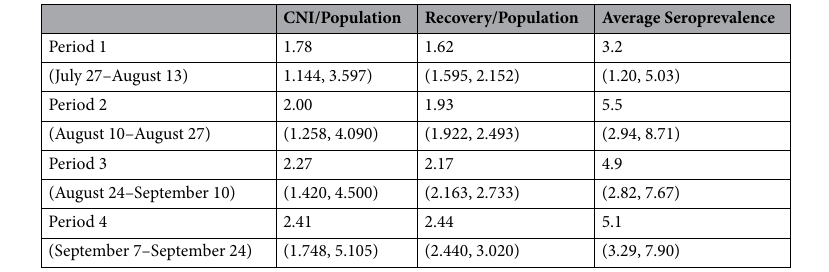
Table 2. Table comparing the seroprevalence estimates for the state